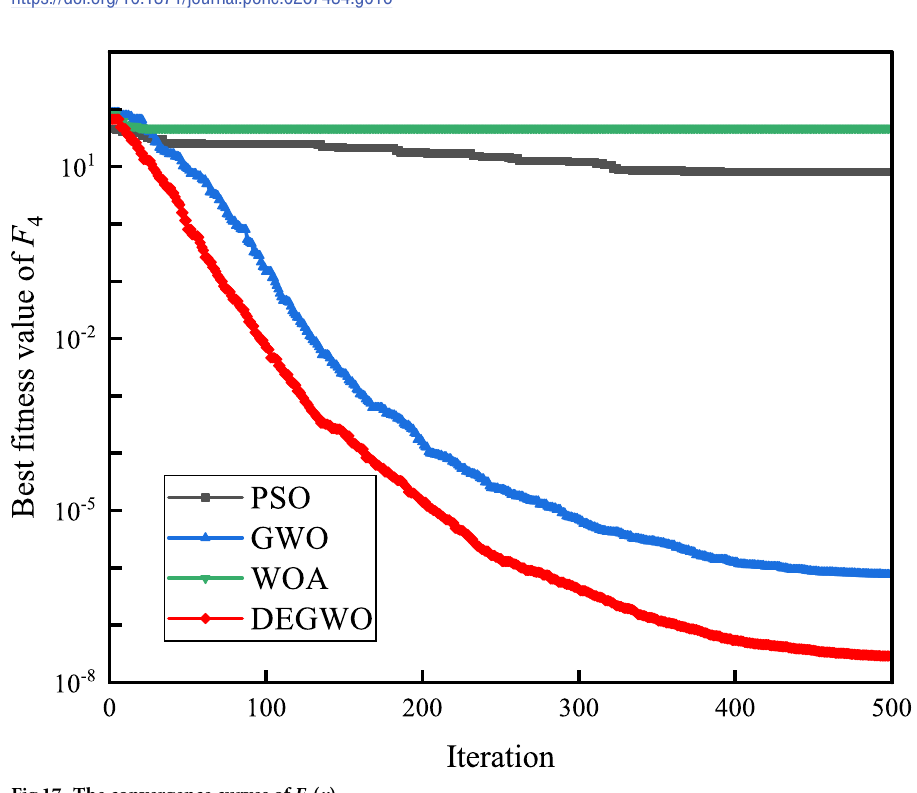
Fig 16. The convergence curves of F 3 ( x ).